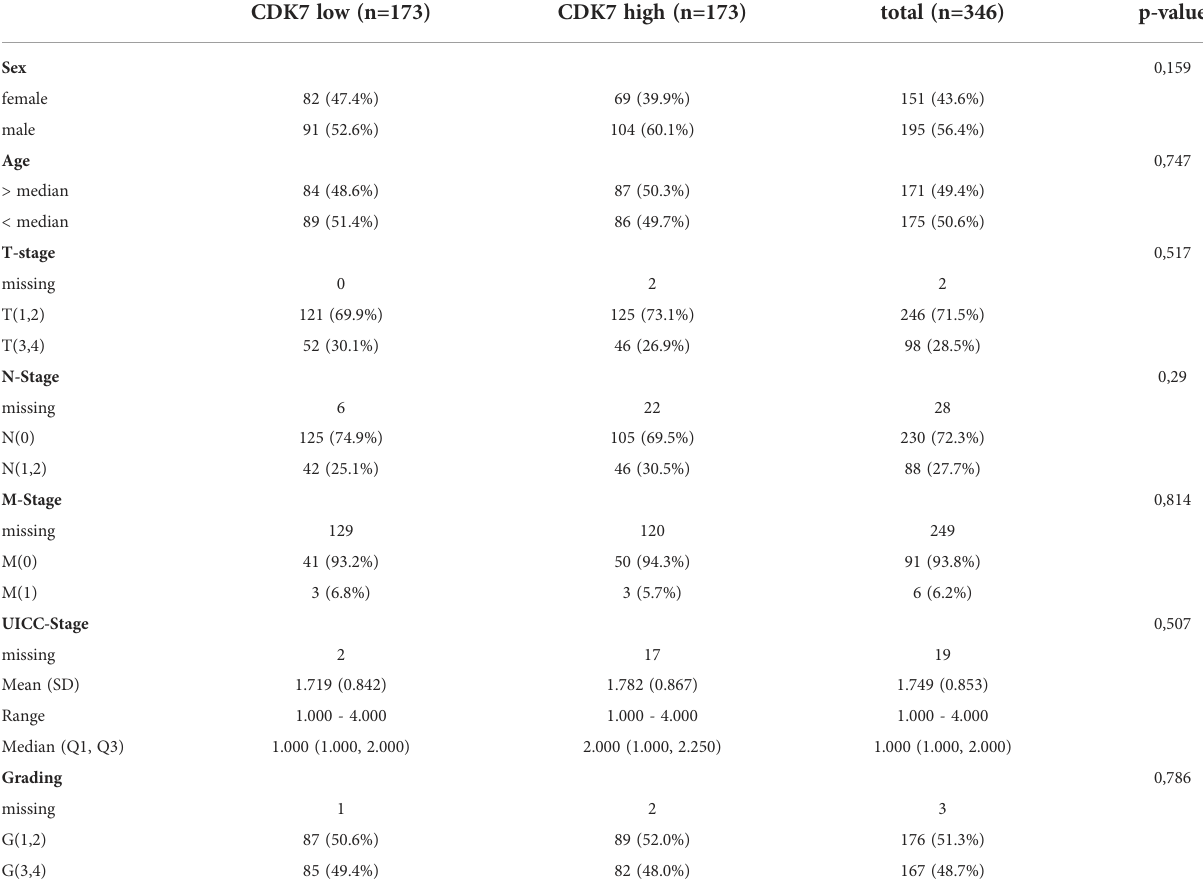
TABLE 1 Overview of clinico-pathological characteristics of CDK7 high and low expressing group.